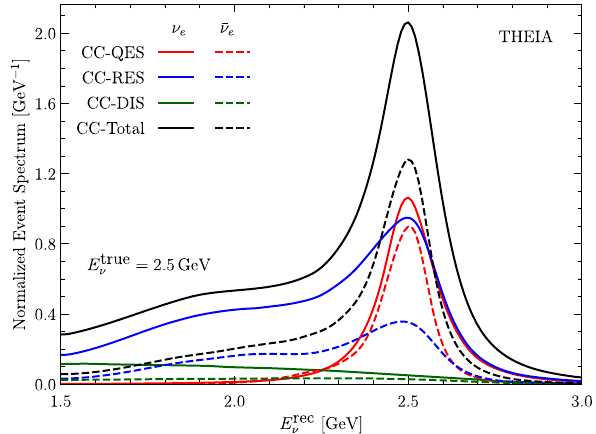
Fig. 8 The reconstructed energies of a 2.5GeV ν e / ¯ ν e neutrino at the THEIA detector for different CC scattering processes: QES (red), RES (blue), and DIS (green). The combined totalspectrum is plottedinblack color.Forcomparison,both ν e (solid)and ¯ ν e (dashed)modesareplotted. Note that the total spectrum for neutrino mode is normalized and the others weighted by their corresponding cross sections for the neutrino (anti-neutrino) mode is adopted to make the reconstructed energy peak at the true value for E ν = 2 .